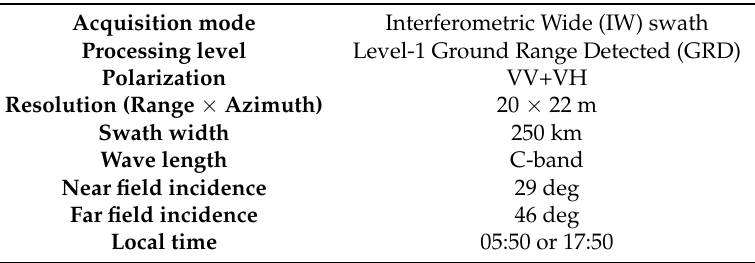
Figure 1. ( a ) Map of average count of Sentinel-1 images per month for the study area in 2017, and ( b ) monthly count of Sentinel-1A and Sentinel-1B images. Table 1. Technical characteristics of the Sentinel-1